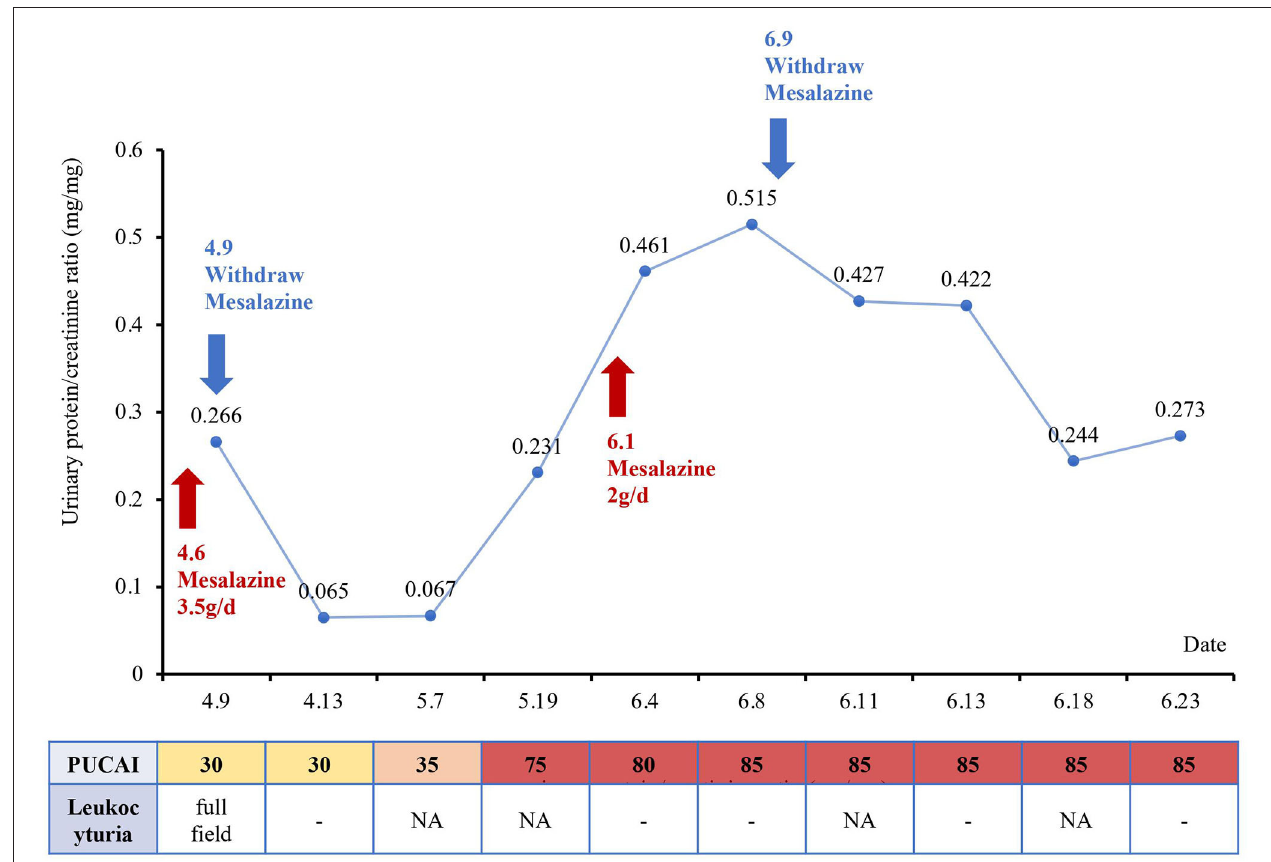
FIGURE 2 | Changes in renal function and the pediatric ulcerative colitis activity index (PUCAI) score over time with the treatment of